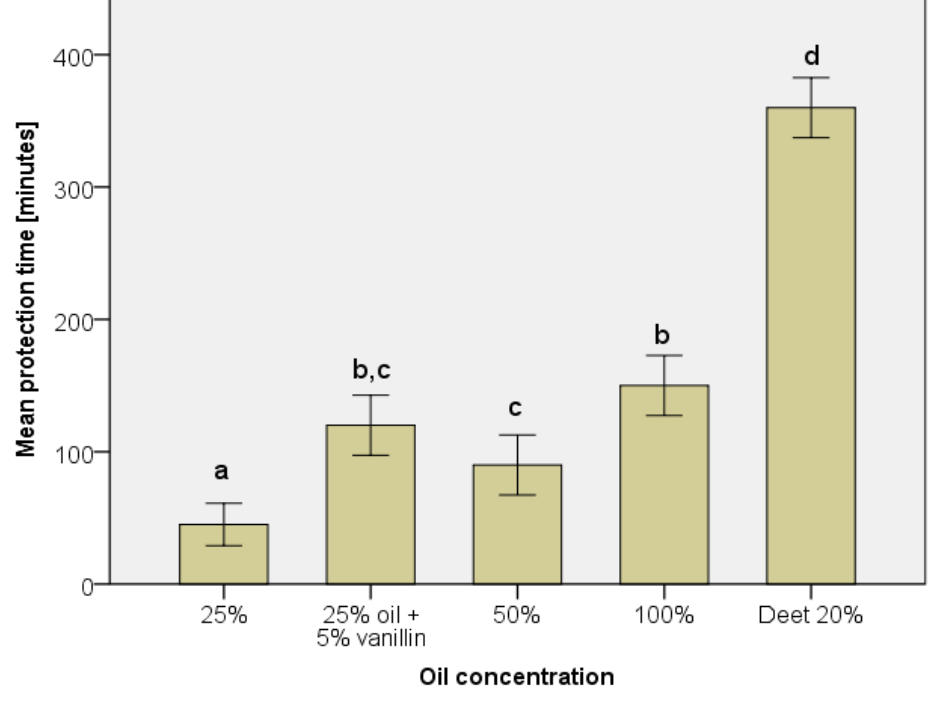
Figure 1. Protection times of Mentha arvensis L. essential oil against Aedes aegypti mosquitoes. Data are shown as mean ± SD ( n = 4). Letters are used to show statistical significance ( p < 0.05). Bars are significantly different if they do not share letters.